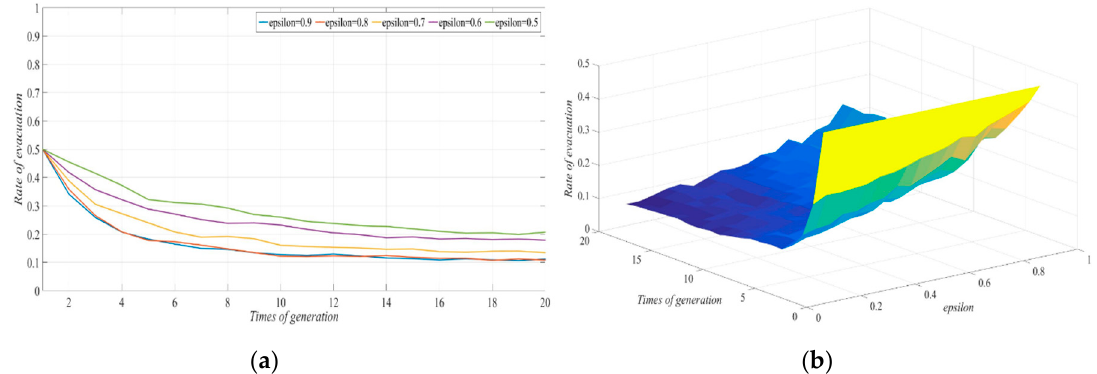
Figure 4. Effect of changes in ε on the evolution of evacuation systems: ( a ) Two-dimension; ( b )